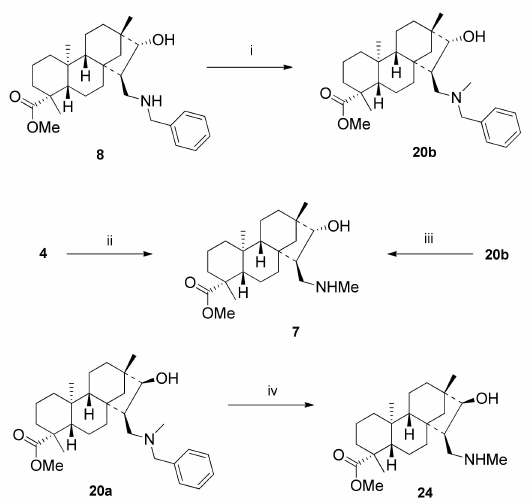
Scheme 7. Alternative determination of the structure of 1,3-aminoalcohols via synthesis. (i) DCM, Et 3 N (1 eq.), MeI (1 eq.), 4 h, 25 ◦ C, 77%; (ii) 1) MeNH 2 (1 eq.), EtOH, 3 h, 25 ◦ C; 2) MeOH, NaBH 4 (2 eq.), 3–4 h, 25 ◦ C, 77%; (iii) MeOH, 5% Pd/C, H 2 (1 atm), 12 h, 25 ◦ C, 24%; (iv) MeOH, 5% Pd/C, H 2 (1 atm), 12 h, 25 ◦ C,